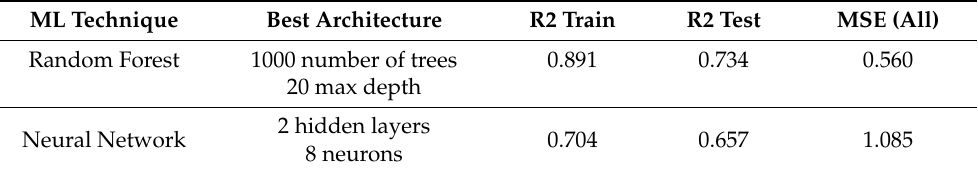
Table 1. Best resulting models for the different techniques in the aggregated approach. ML